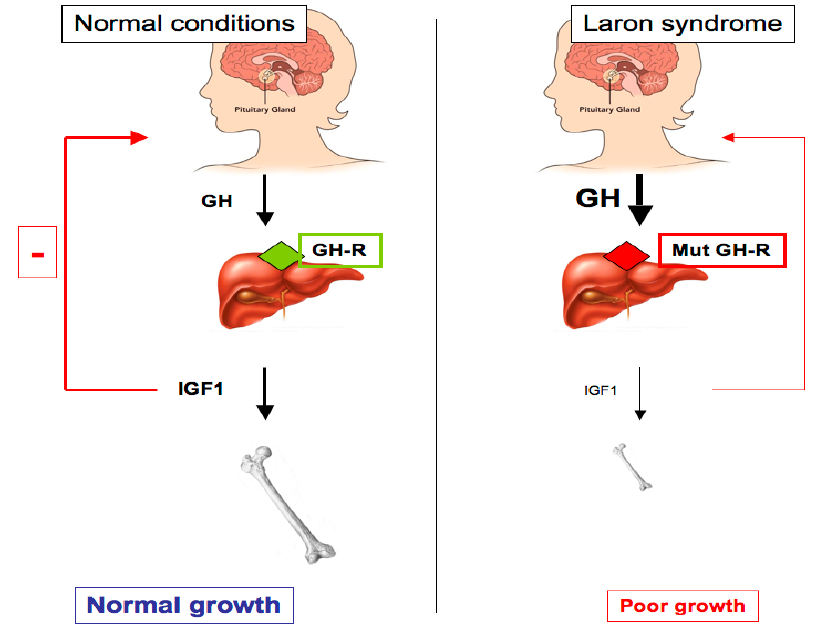
Figure 1. Schematic representation of the GH-IGF1 axis in health and in Laron syndrome (LS) patients. Pituitary-produced GH leads to IGF1 secretion from the liver, with ensuing bone elongation and longitudinal growth (left panel). As a result of a GH-R mutation in LS patients, the liver (and, probably, additional extrahepatic tissues) is no longer able to produce physiological levels of IGF1 (right panel). Abrogation of IGF1 production leads to impaired growth and defective negative feed-back at the pituitary gland level, leading to high circulating GH levels.